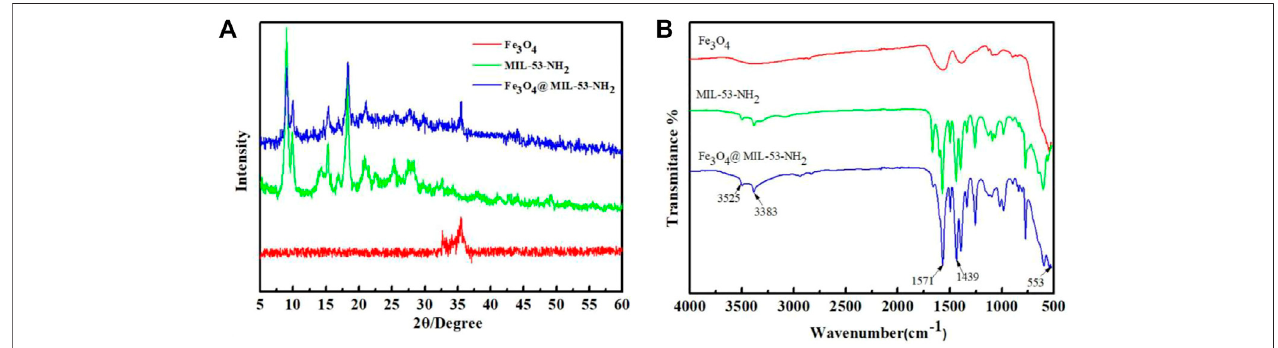
FIGURE 1 | (A) XRD pattern of Fe 3 O 4 -COOH, MIL-53(Al)-NH 2 and Fe 3 O 4 @MIL-53(Al)-NH 2 ; (B) FT-IR spectra of Fe 3 O 4 -COOH, MIL-53(Al)-NH 2 and Fe 3 O 4 @MIL- 53(Al)-NH